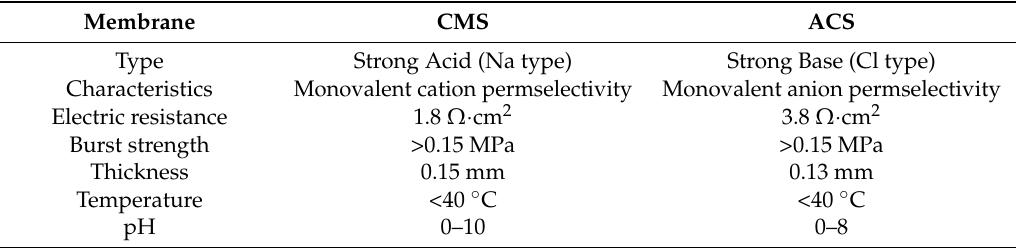
Table A1. Membrane specification of the membranes used.